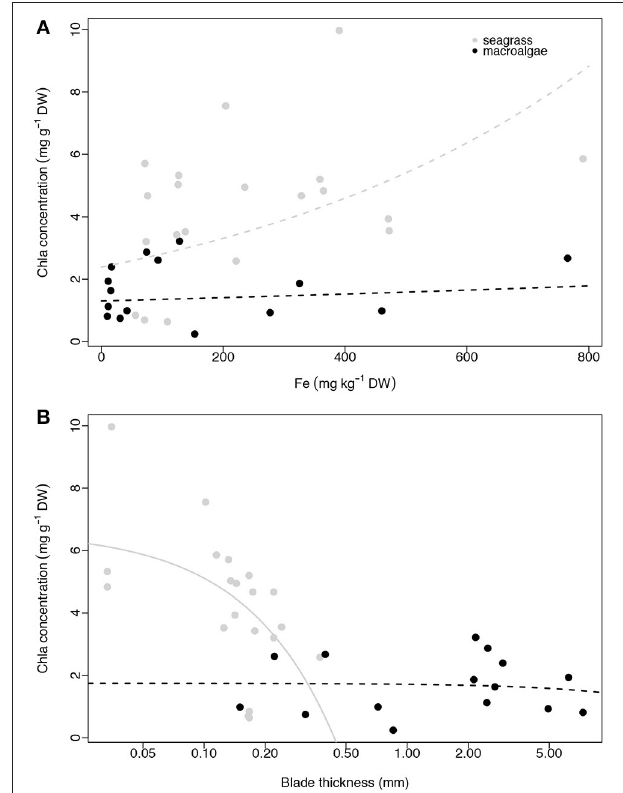
FIGURE 5 | Relationship between average Chl a concentration (mg g − 1 DW) and average iron concentration (mg kg − 1 DW; A ) and average blade thickness (mm; B ) per species per site. Seagrasses are depicted with gray dots and macroalgae with black dots. Significant regressions ( p < 0.05) are represented with a solid line and non-significant regressions are indicated with a dash line. The number of replicates is indicated in Table 2 .